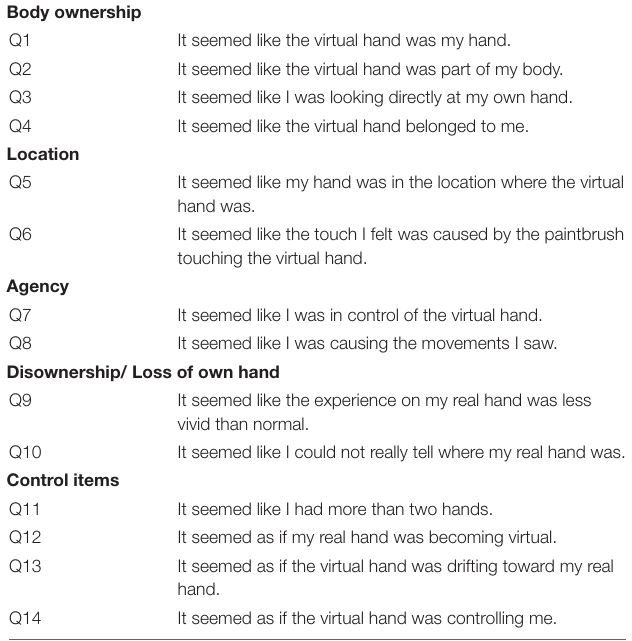
TABLE 2 | Embodiment Questionnaire